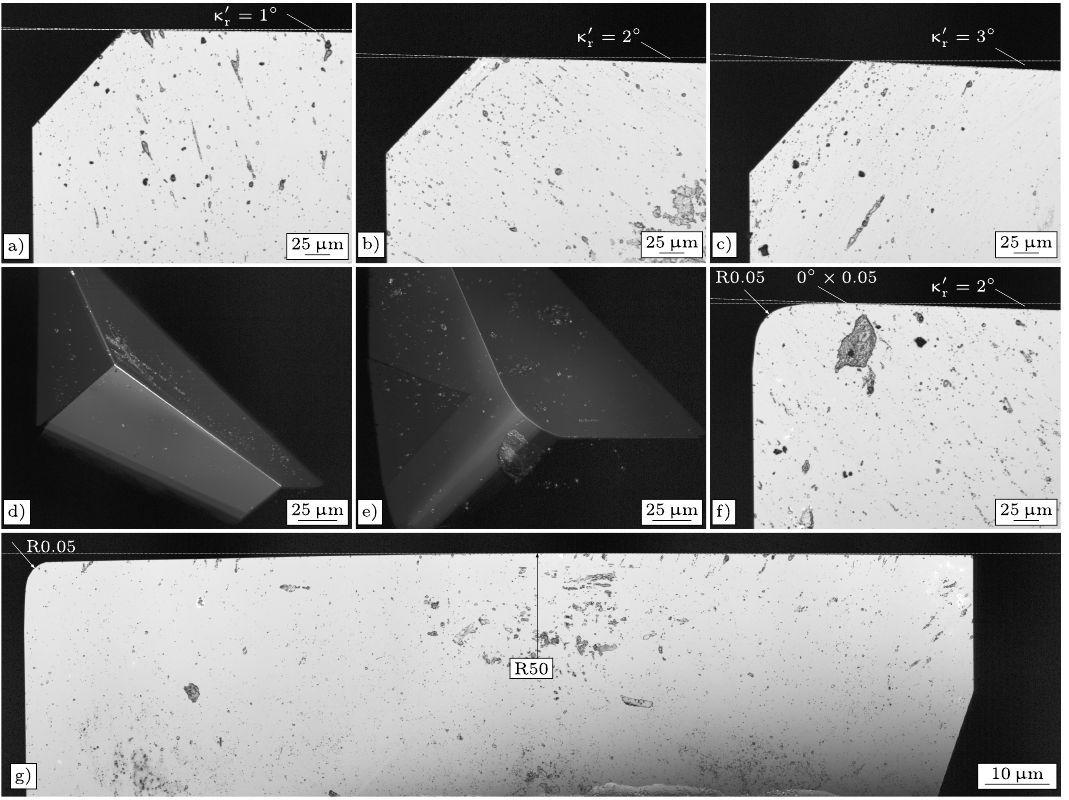
Figure 2. Different geometries of mono crystalline diamond (MCD)-tipped tools ( a – c ) chamfered corner and straight minor cutting edge with cutting edge angles κ (cid:48) r = 1 ◦ , 2 ◦ , and 3 ◦ , ( d ) corner chamfer F0.1 45 ◦ , ( e ) corner radius R0.05, ( f ) trailing × cutting edge with corner radius R0.05-0 ◦ 0.05, and ( g ) arched cutting edge with corner radius ×